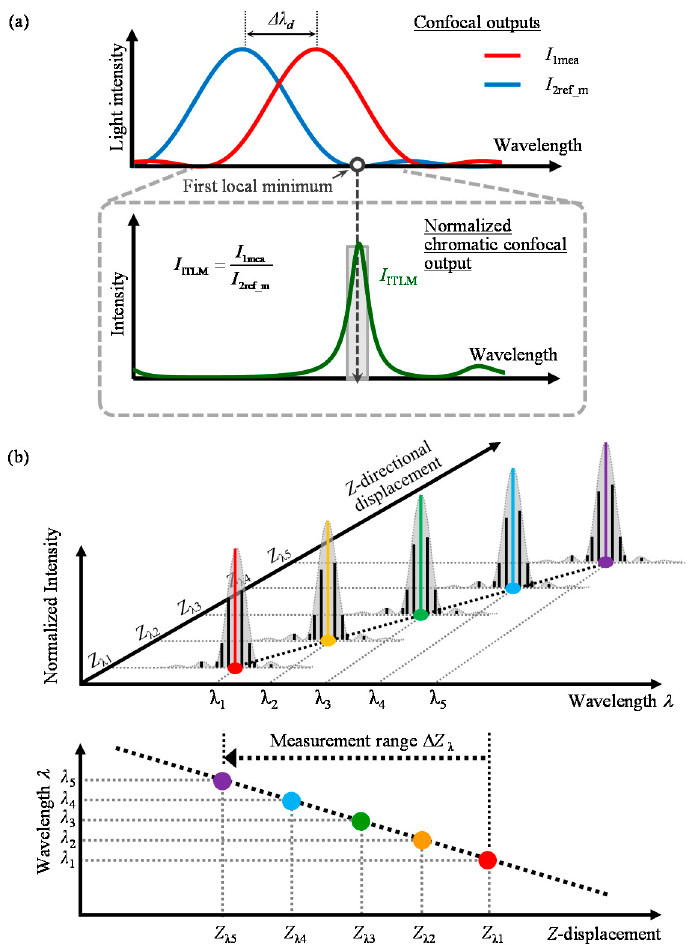
Figure 5. A schematic of the tracking local minimum (TLM) algorithm. ( a ) The normalized output obtained from the reference output and the measurement output [30]; ( b ) a schematic of the wavelength-to-displacement encoding in the TLM method.